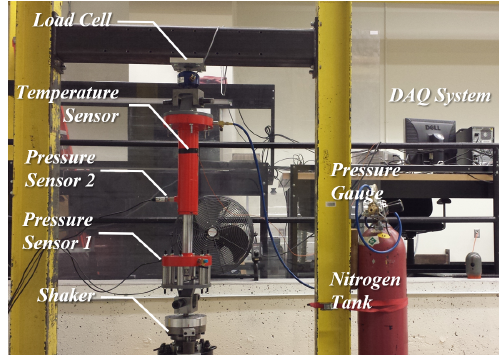
Figure 7. Experimental setup for hydropneumatic suspension. The top of the cylinder is fixed on a beam. Excitation is applied on the bottom of the piston by a shaker. A load cell is installed between the beam and cylinder. The pressure sensor 1 is installed on the bottom of the piston to measure gas pressure in chamber 1. The pressure sensor 2 is installed to measure the oil pressure in the hydraulic chamber. The shaker system has displacement and velocity sensors.